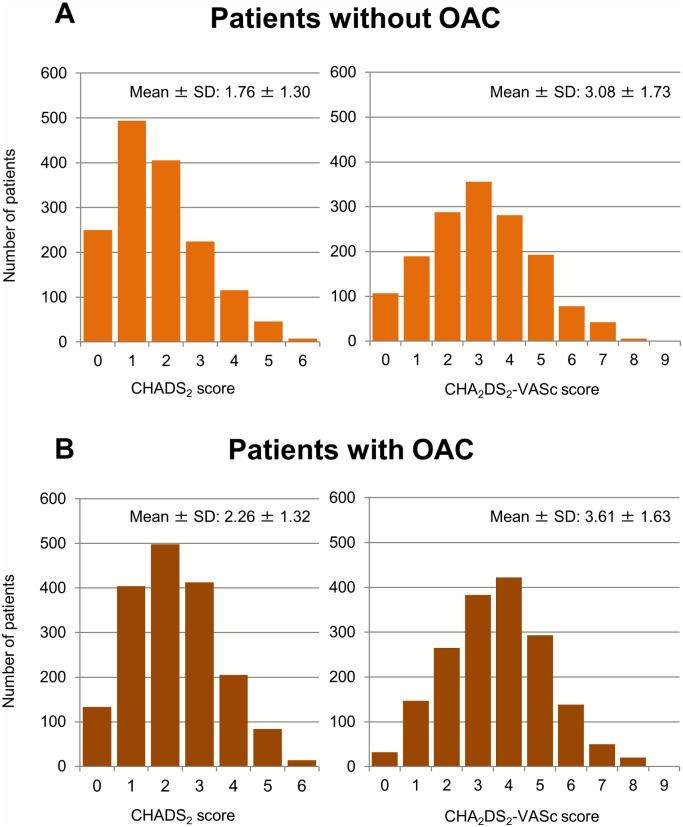
Distribution of patients for each CHADS2 and CHA2DS2-VASc score.(A) Patients without oral anticoagulant (OAC). (B) Patients with OAC. SD: standard deviation.